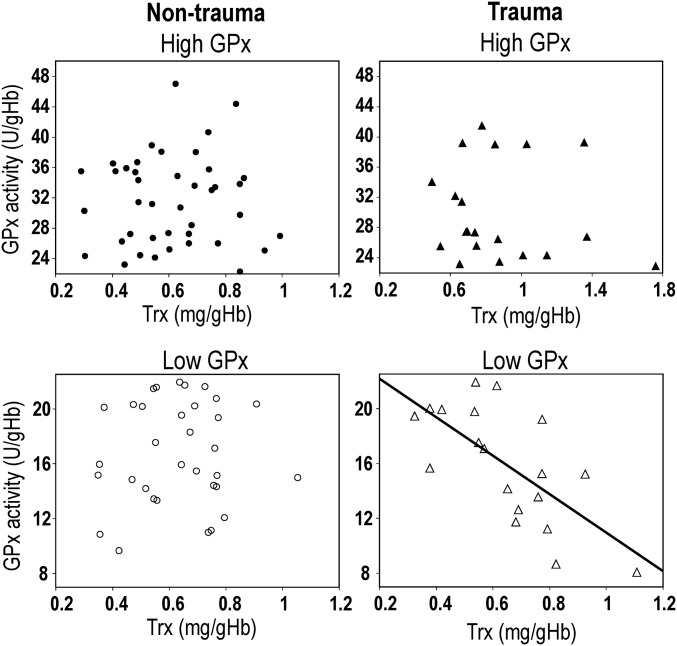
Compensatory regulation of the Trx/Prx system in trauma patients with low-GPx activity in blood. Scatterplots illustrate the relation between active Trx levels [milligrams per gram of Hb (mg/gHb)] and blood GPx activity [units per gram of Hb (U/gHb)] in EPP−NT (Left) and EPP+CT (Right) with high blood GPx activity (Top) and with low blood GPx activity (Bottom). Trx levels and GPx activities correlated negatively in low-GPx EPP+CT (r = −0.725, P = 0.0015). No correlations were detected in the other groups.